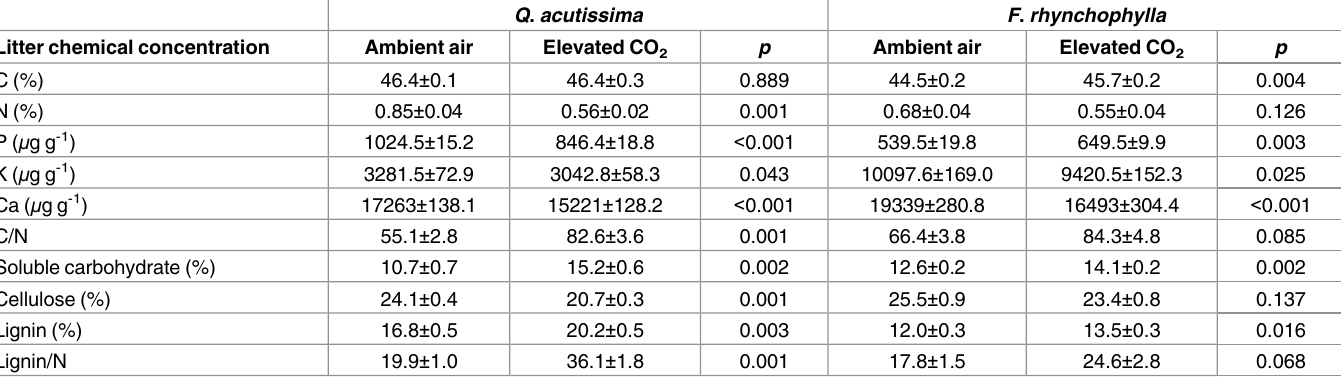
Table 2. Chemical concentrations of leaf litter collected from the ambient air and elevated CO 2